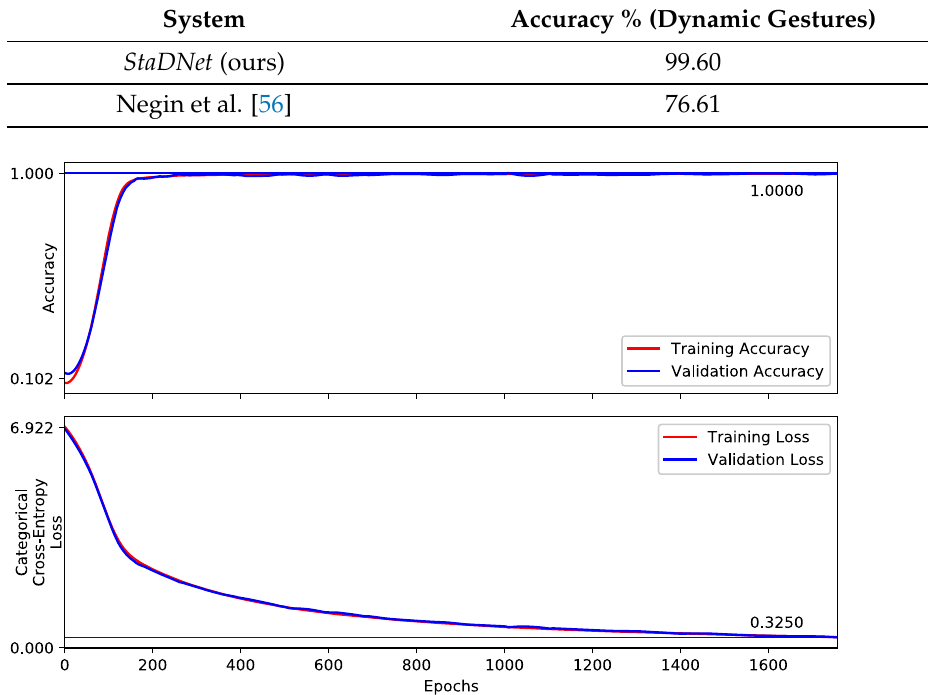
Table 2. Comparison of dynamic gestures recognition results on the Praxis gestures dataset; [56] also used a similar CNN-LSTM network.